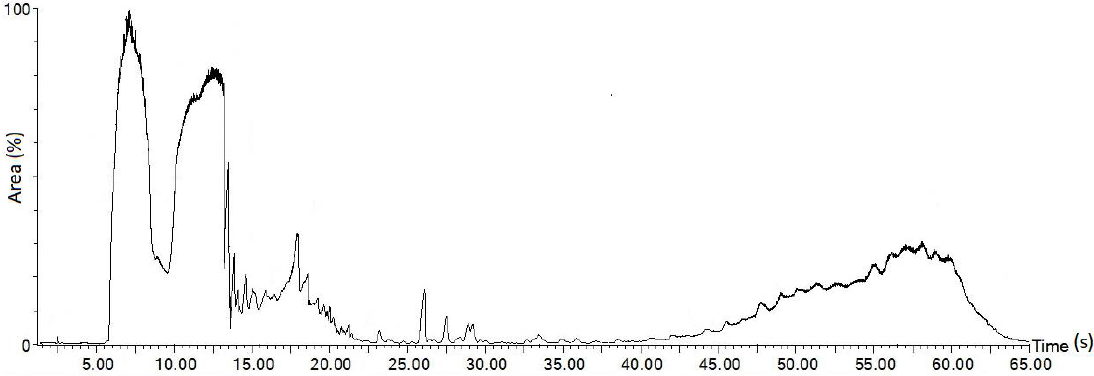
Figure 6. Chromatogram of Melaleuca Cajuputi oil.